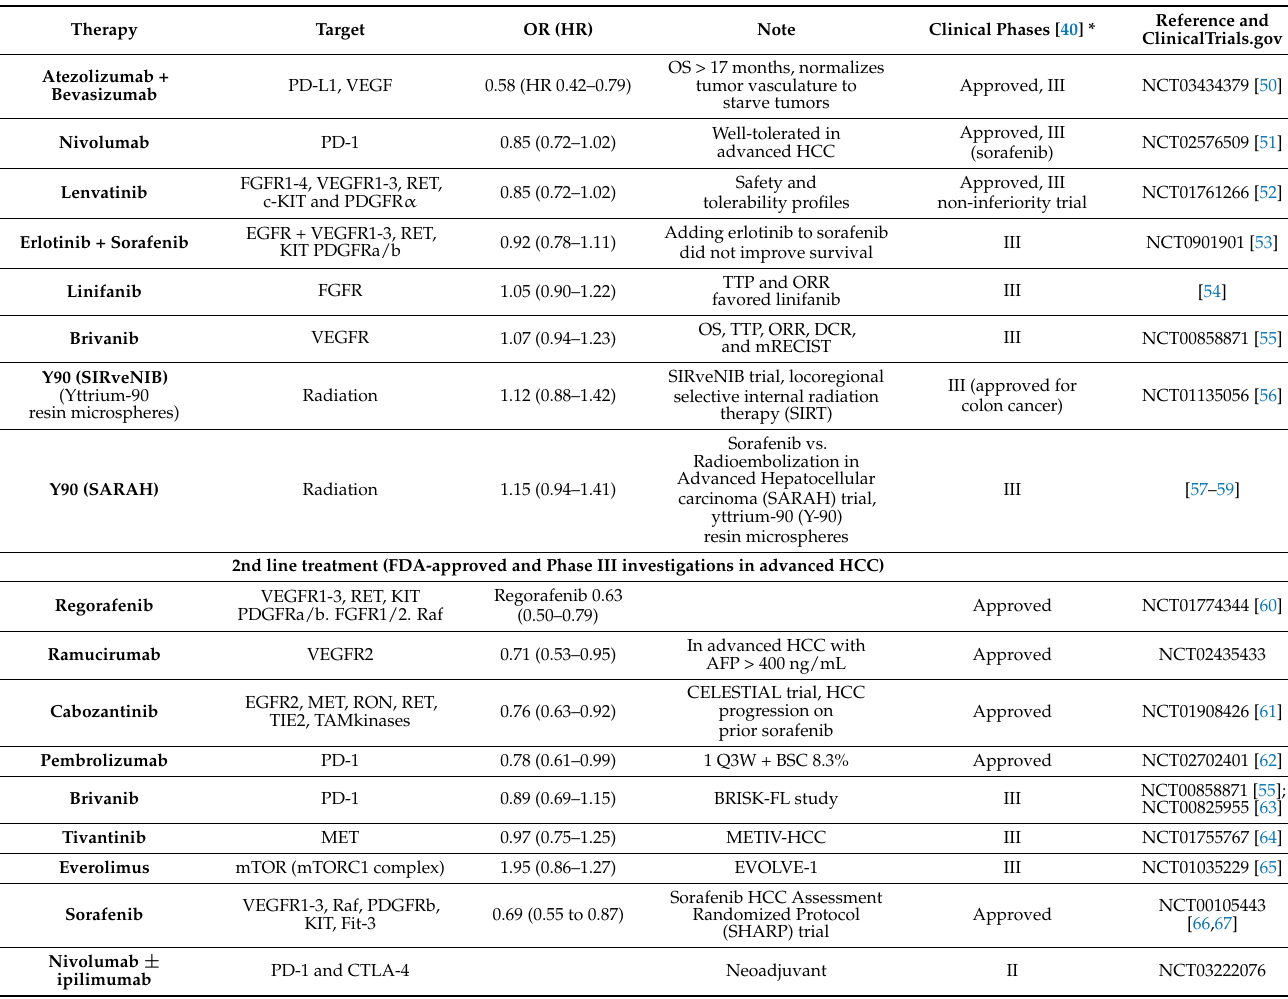
Table 1. First line therapy (FDA-approved and Phase III investigations in advanced